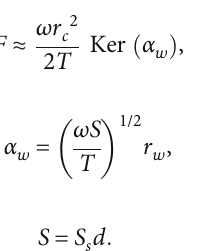
Figure 5: Illustration of an idealized well in a con fi ned aquifer. Note: r is the drawdown of the pressure head. d is the aquifer